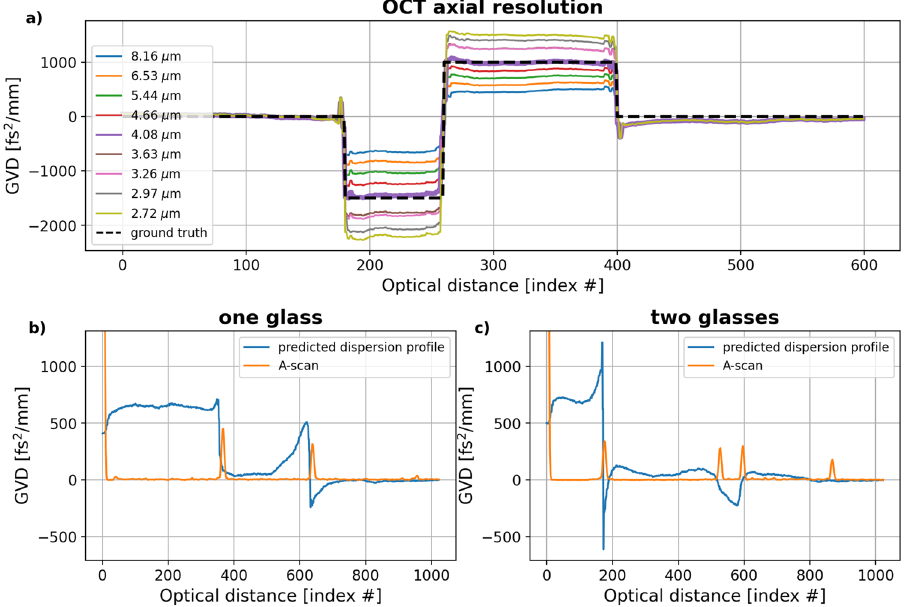
2 2 /mm and 1,000 fs /